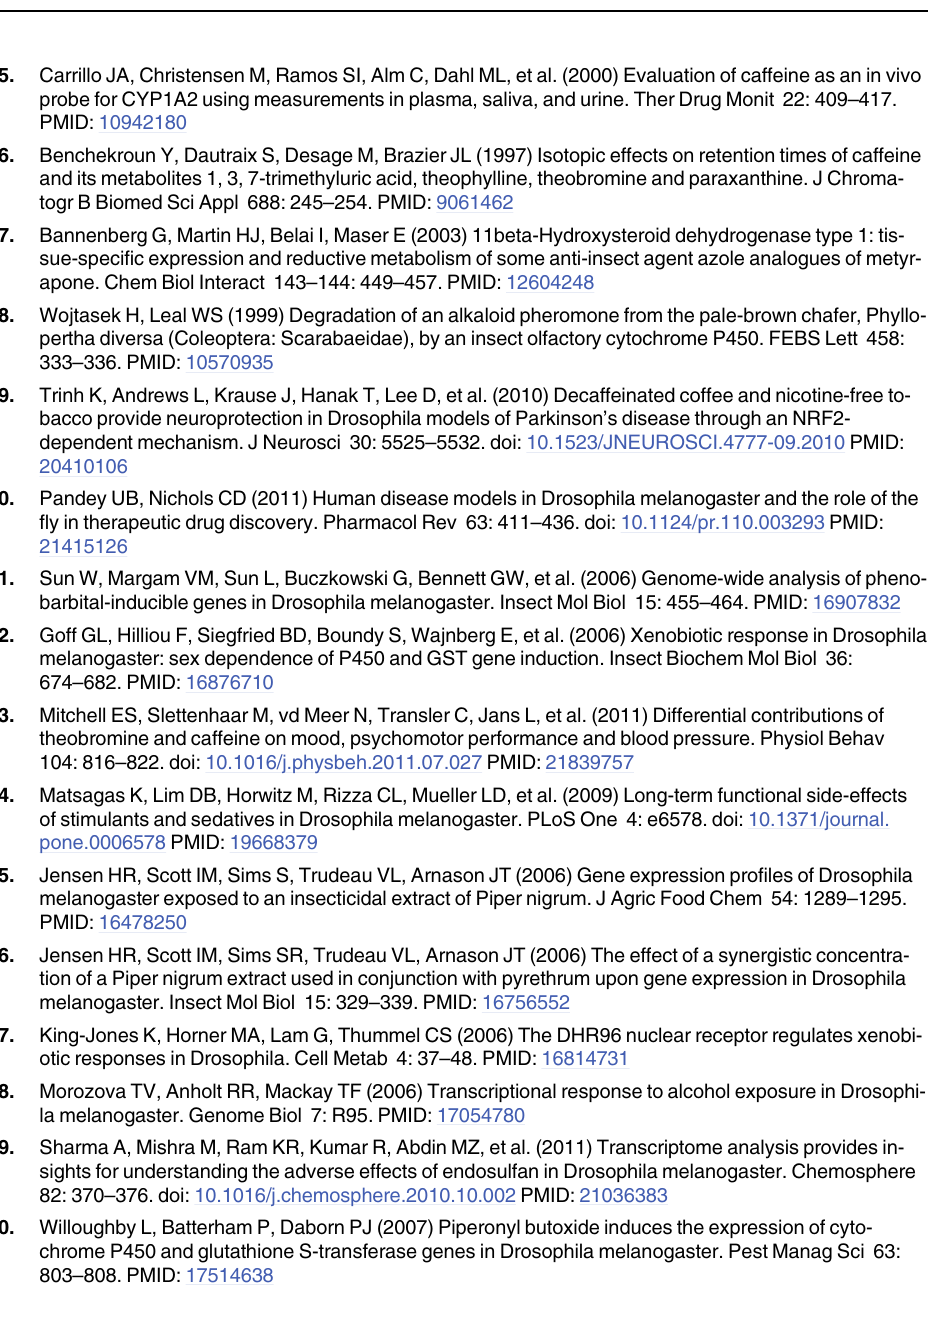
PLOS ONE | DOI:10.1371/journal.pone.0117328 February 11,